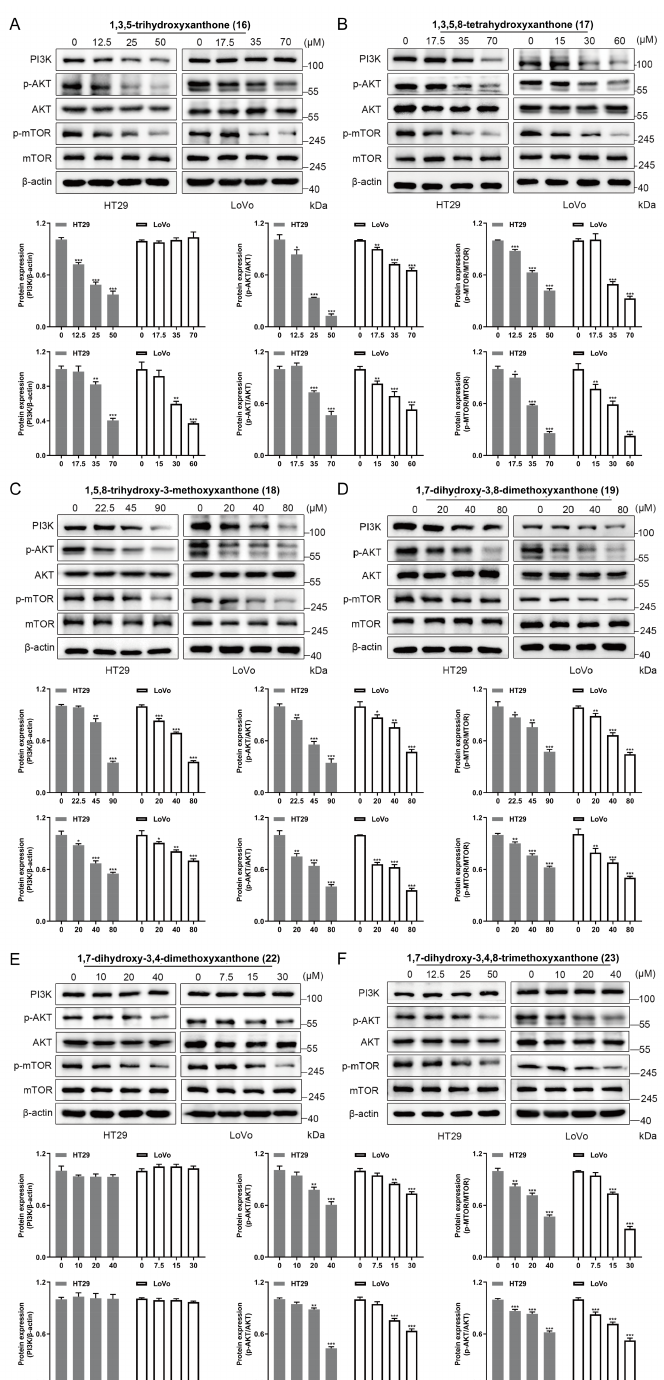
Figure 7. The regulation of xanthones 16 – 19 , 22 and 23 on PI3K/Akt/mTOR signaling pathway in vitro. Expression and statistics of PI3K, p − Akt (Ser473)/Akt, p − mTOR (Ser2448)/mTOR proteins detected after treatment of HT29 and LoVo cells with compounds ( A ) 1,3,5 − trihydroxyxanthone ( 16 ); ( B ) 1,3,5,8 − tetrahydroxyxanthone ( 17 ); ( C )1,5,8 − trihydroxy-3-methoxyxanthone ( 18 ); ( D ) 1,7 − dihydroxy − 3,8 − dimethoxyxanthone ( 19 ); ( E ) 1,7 − dihydroxy − 3,4 − dimethoxyxanthone ( 22 ); ( F ) 1,7 − dihydroxy − 3,4,8 − trimethoxyxanthone ( 23 ), respectively. Values represent the mean ± SEM of three determinations. * p < 0.05; ** p < 0.01; *** p < 0.001 (Differences between compound-treated group and control group). n =